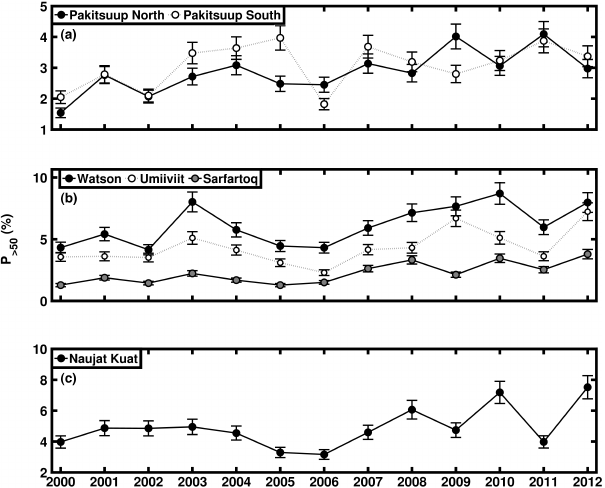
Figure 10. P > 250 for yearly melt season with error bars for (a) Pak- itsuup, (b) Kangerlussuaq, and (c) Ameralik fjord